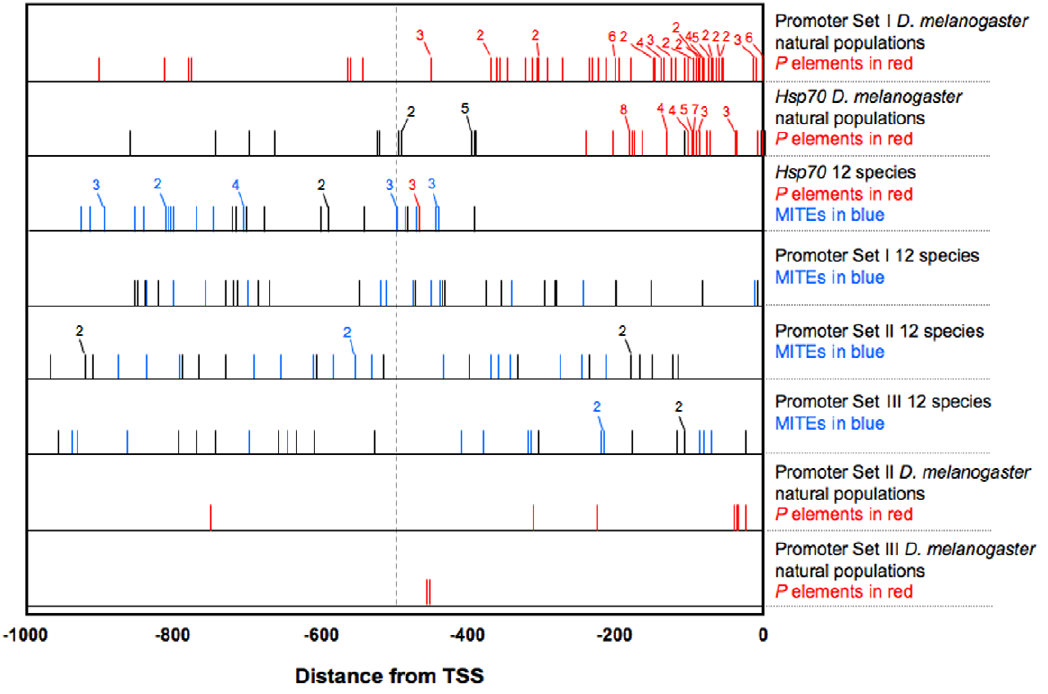
Figure 4. Insertion sites of TEs in three single-copy promoter sets and Hsp70 promoters in the 12 sequenced genomes, and in similar promoters of natural populations of D.melanogaster . Data for D. melanogaster natural populations was taken from [2]. Due to shared insertions in all genesets, and gene duplication and the spatial arrangement of Hsp70 copies, some individual TE insertions occur in more than one promoter. Distance to TSS of shared insertions is shown for all promoters in which the insertion is found.